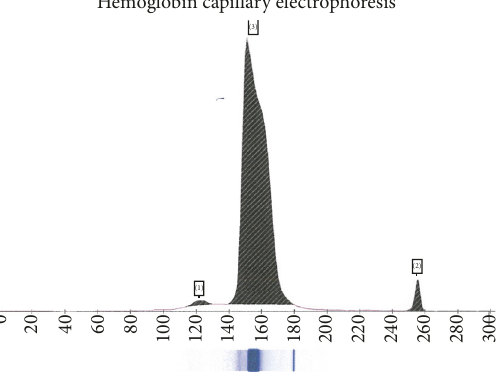
Figure 2: Sebia hemoglobin capillary electrophoresis. Fraction (1): hemoglobin F 0.7%; Fraction (2): hemoglobin A2 2.9%; Fraction (3): beta globin variant and closely located Hemoglobin A: